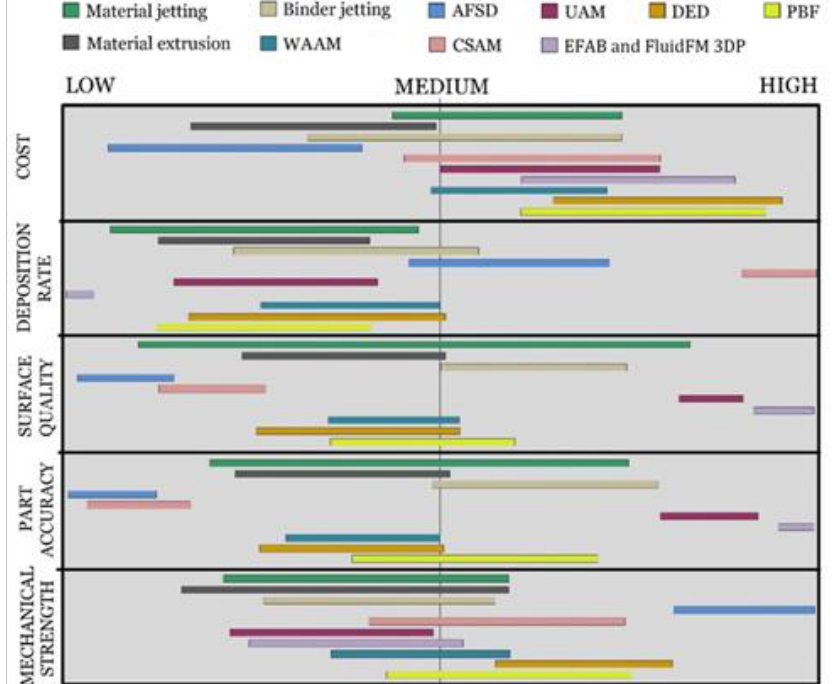
Figure 16. The identification map of the beamless metal AM technologies in comparison with DED and PBF beam-based methods. As can be seen, AFSD offers the highest mechanical strength and the lowest process and operation cost. Extrusion process is also a low-cost process suitable for low-volume production, while CSAM offers the highest deposition rate (up to 38 kg/h). EFAB and FluidFM 3DP processes possess the highest dimensional accuracy and surface quality.